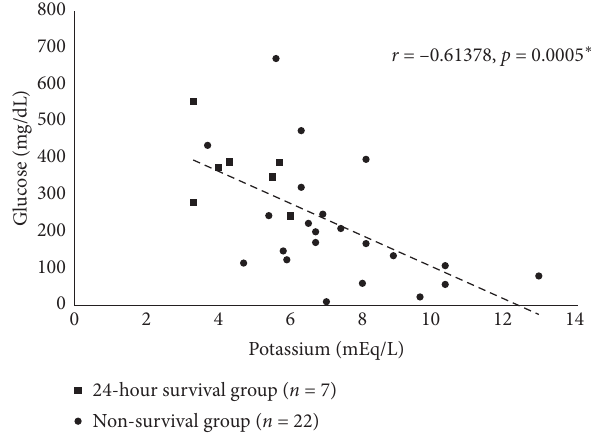
Figure 1: Correlation between the serum potassium and blood glucose levels ( n �